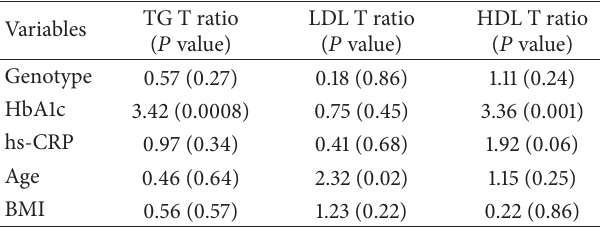
Table 4: Multiple regression analysis of cardiovascular risk